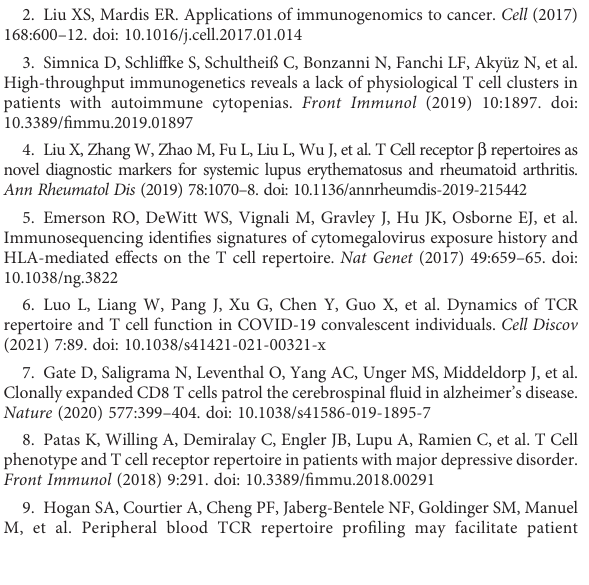
SUPPLEMENTARY FIGURE 1 Theclonotypecountswereshowningroupsbyhospitalizationstatus.The patients that were not hospitalized were shown in blue while the patients thatwerehospitalizedwereshowninorange.Differenttypesofplotswere shown as follows: (A) violin plot (B) strip plot (C) swarm plot (D) box plot (E) boxen plot (F) point plot (G) bar plot. SUPPLEMENTARY FIGURE 2 Clonal portiongrouped by hospitalizationstatus.The y-axispresented the number of clonotypes that counted for 10% of all the clonotypes in the repertoire. The patients that were not hospitalized were shown in blue while the patients that were hospitalized were shown in orange. Different typesofplotswereshownasfollows: (A) violinplot (B) stripplot (C) swarm plot (D) box plot (E) boxen plot (F) point plot (G) bar plot. SUPPLEMENTARY FIGURE 3 The distribution of clonotype groups in each sample. (A) The distribution of clonotype groups was based on the clonotype frequency across all the clonotypes. Hyperexpanded clonotypes (blue) were the clones with frequencies between 0.01 to 1, large clonotypes (orange) were the clones with frequencies between 0.001 to 0.01, medium clonotypes (green) were the clones with frequencies between 0.0001 to 0.001, small clonotypes (red) were the clones with frequencies between 0.00001 to 0.0001, rare clonotypes (purple) were the clones with frequencies between 0 to 0.00001. (B) The distribution of clonotype groups based on the clonotype count across the top 100 clonotypes. The clonotypes with clone counts between 1001-5000 were presented in blue, the clonotypes with clone counts between 101-1000 were resented in orange, and the clonotypes with clone counts between 11-100 were presented in green. (C) The distribution of clonotype groups based on the clonotype count across the rare 100 clonotypes. The clonotypes with clone count of 1 were presented in blue. SUPPLEMENTARY FIGURE 4 Heatmap of the weighted V gene usage in each sample and the Sankey plot for V-J combinations. (A) The heatmap of V gene weighted usage (B) The hierarchically-clustered heatmap of V gene weighted usage. x-axis